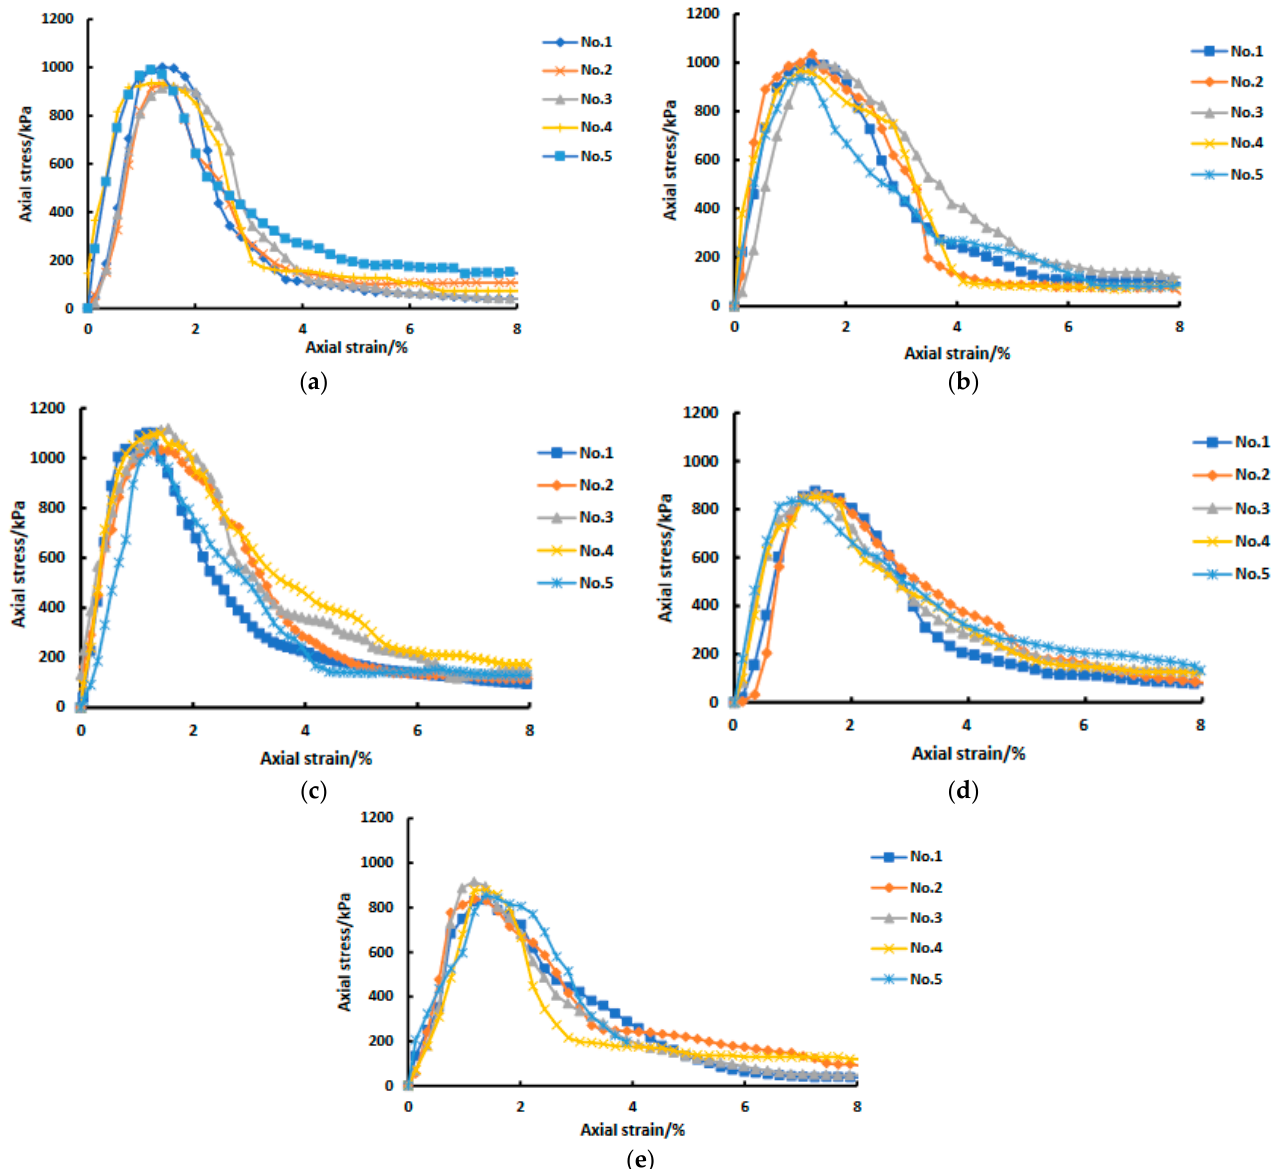
Figure 7. Stress–strain curves of TCS with different iron tailing contents. ( a ) STCS-0-0; ( b ) STCS-0-10; ( c ) STCS-0-20; ( d ) STCS-0-30; ( e ) STCS-0-40.